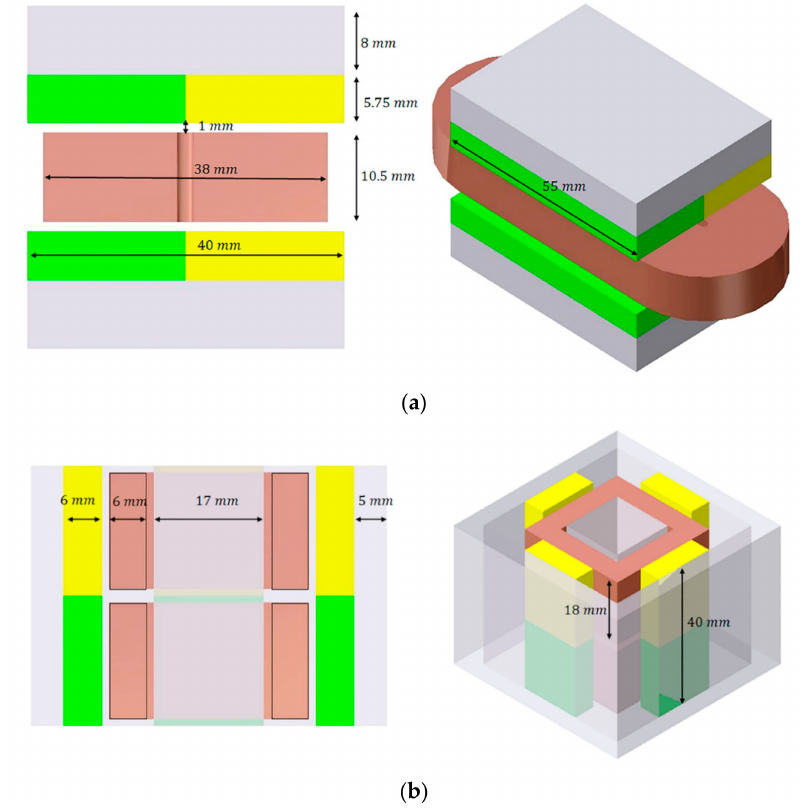
Figure 10. The optimized design parameters ( a ) HVCM, ( b )